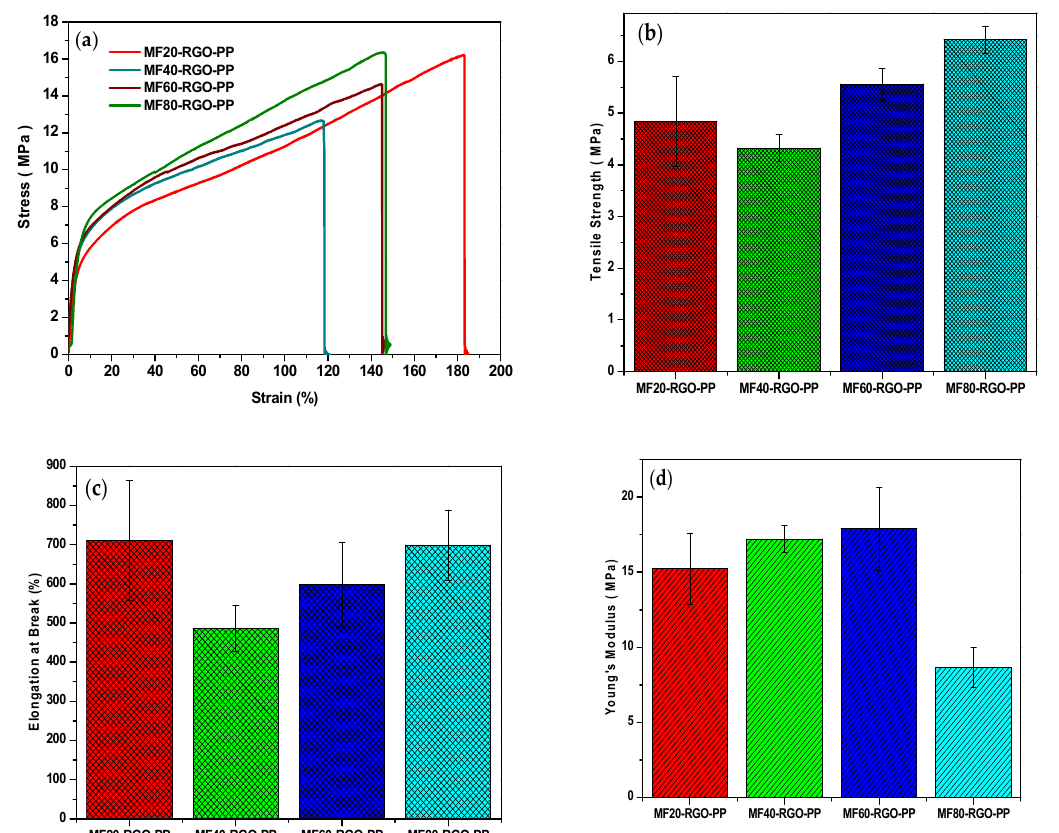
Figure 17. Mechanical behavior of prepared MF20-RGO-PP, MF40-RGO-PP, MF60-RGO-PP and MF80-RGO-PP nanocomposites: ( a ) representative strain–stress curves, ( b ) the tensile strength, ( c ) elongation at break and ( d ) Young’s modulus.